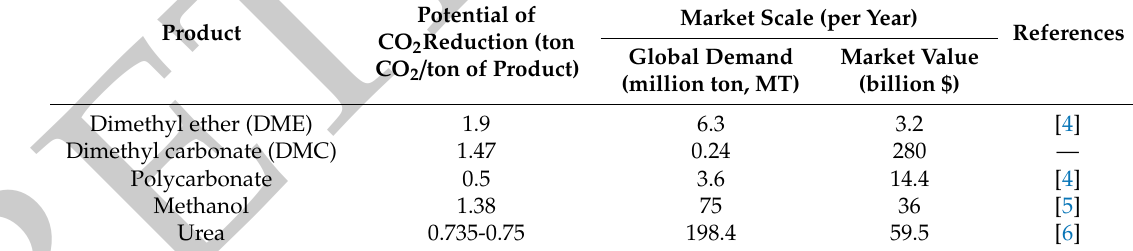
Table 1. CO 2 reduction and market sales potential of di ff erent products formed by CO 2